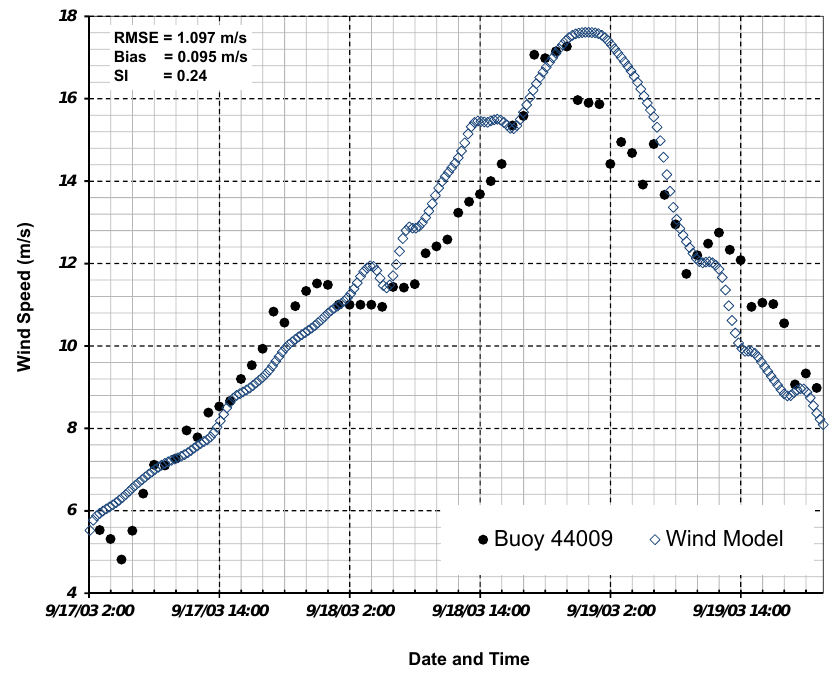
Figure 6. Comparison of calculated and observed wind speed at NOAA Buoy 44009. Location of the buoy is shown in Figure 1 with green filled